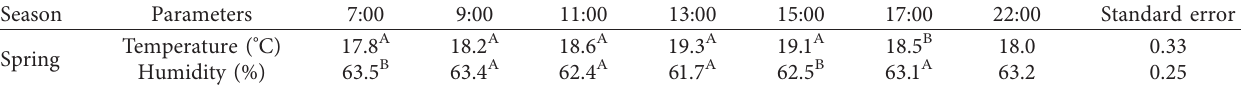
Table 1: Daily change of temperature and humidity in the hog house.